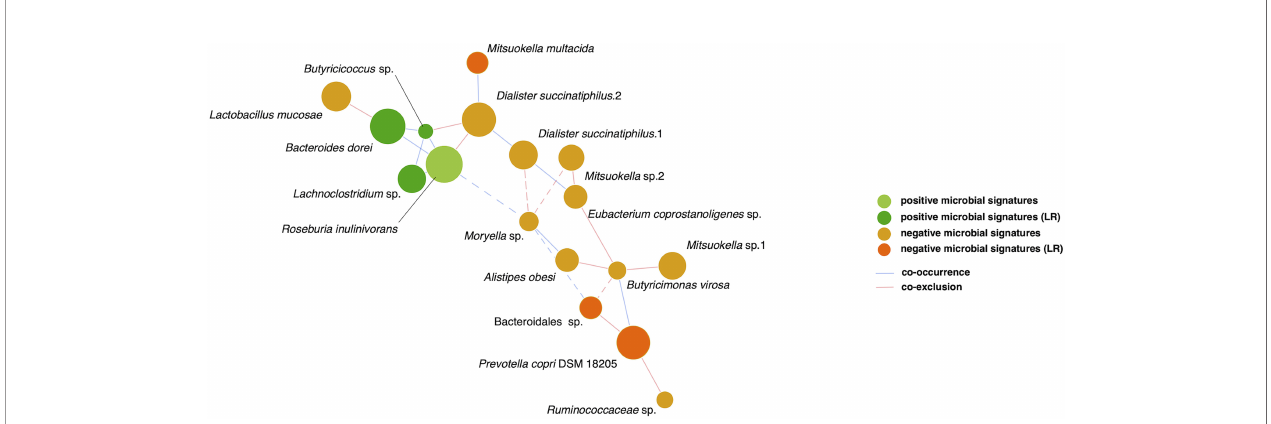
FIGURE 4 | SparCC network of glycemic response-associated microbial signatures for GLP-1 RA treatment. The 17 distinct features with either positive correlation (green nodes) or negative correlation (orange nodes) to blood glucose reduction show co-occurrence (blue edges) or co-exclusion (red edges) between others in relationships. The 6 features remained in linear regression (LR) models are shown as deep color nodes. The size of a node is directly correlated to the respective abundance of microbial feature. The magnitude of the correlation is expressed as the inverse length of the respective edge. An absolute correlation magnitude < 0.2 (SparCC correlation) is presented in dotted